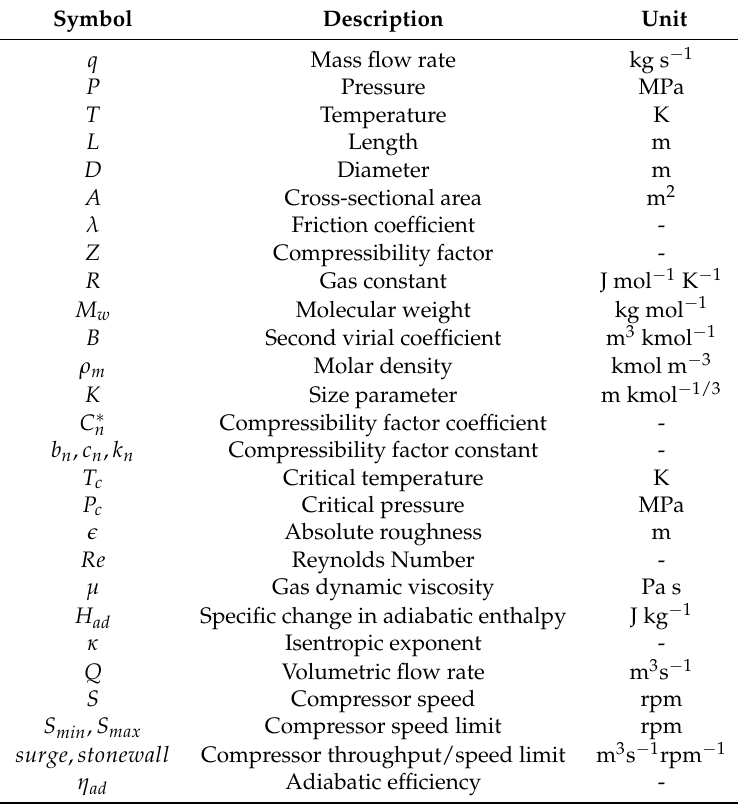
Table 1. Parameters and variables describing gas